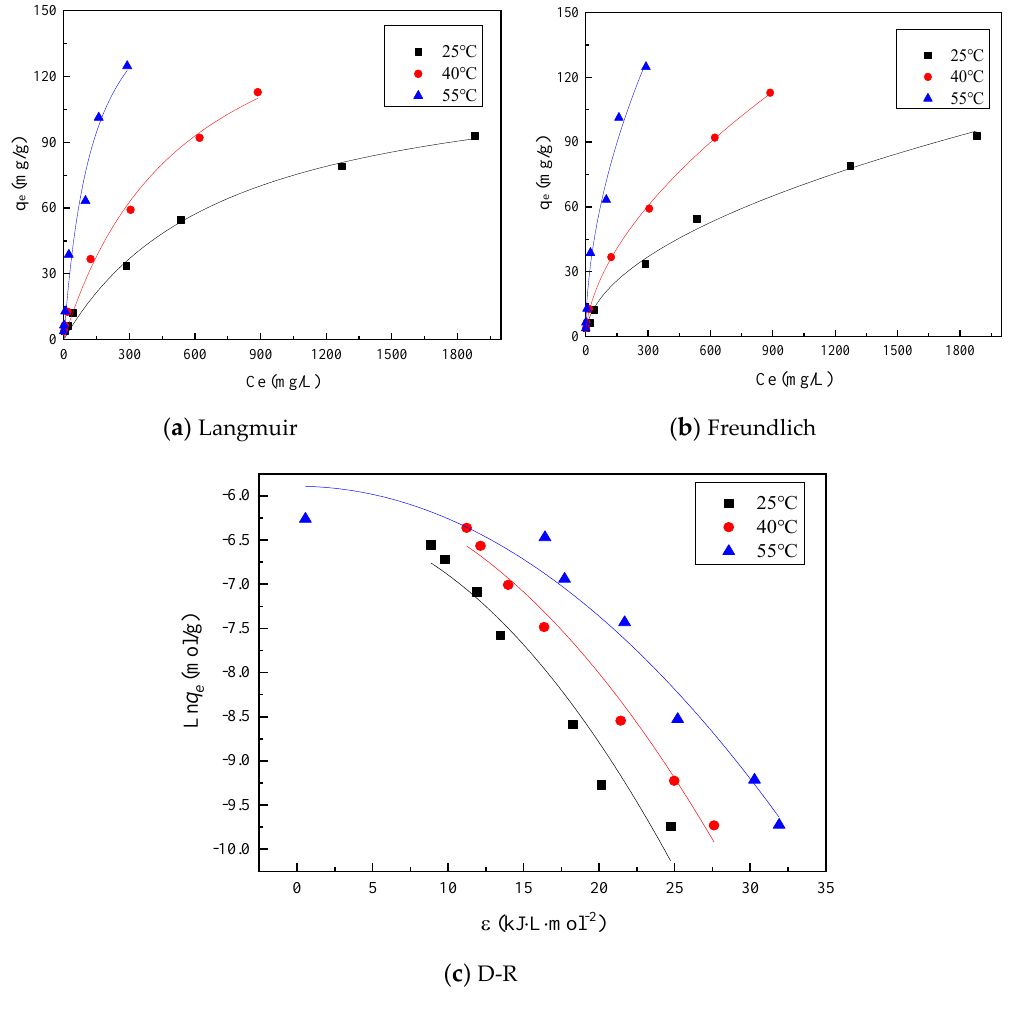
Figure 4. Adsorption model. Table 3. Adsorption model parameters.